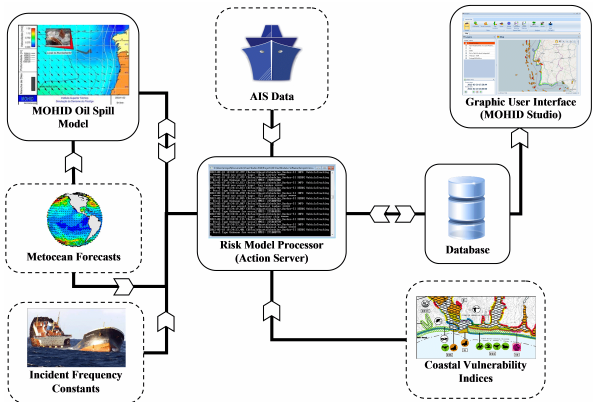
Figure 2. General information workflow in the risk modelling sys-